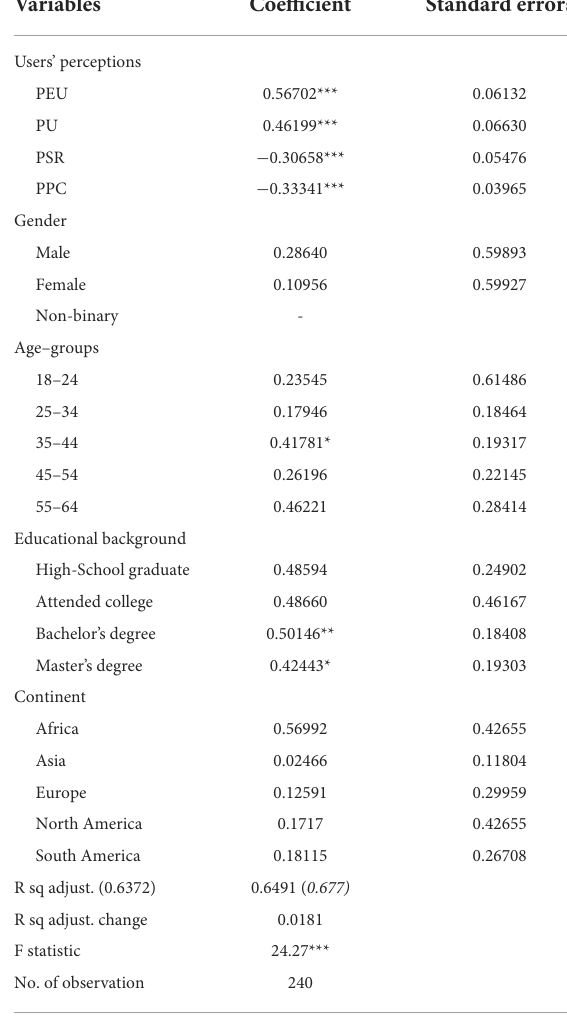
TABLE 12 Regression for demographic and control